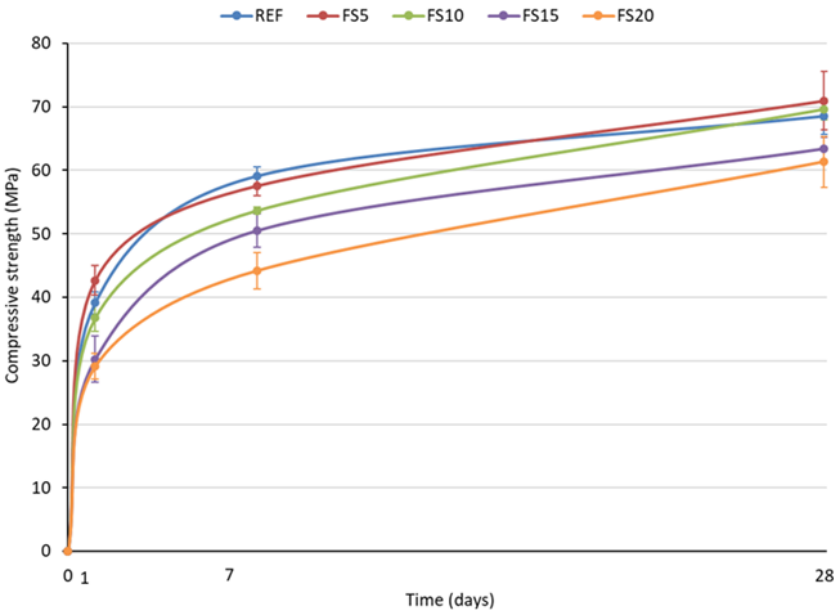
Figure 12. Compressive strength of nonprinted mortars at 1, 7, and 28 days.